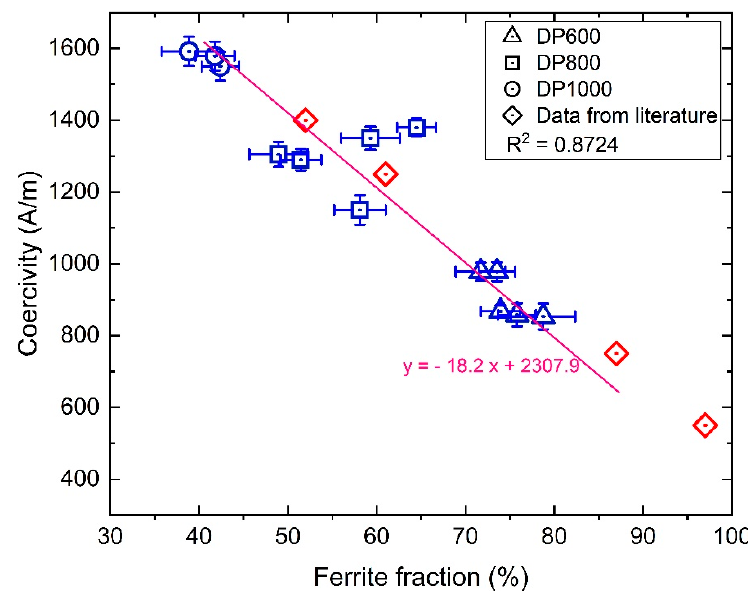
Figure 4. Coercivity measurement versus ferrite fraction for the commercial DP600, DP800 and DP1000 steel samples compared to a set of laboratory heat-treated dual phase steel from Martinez et al. [22] .